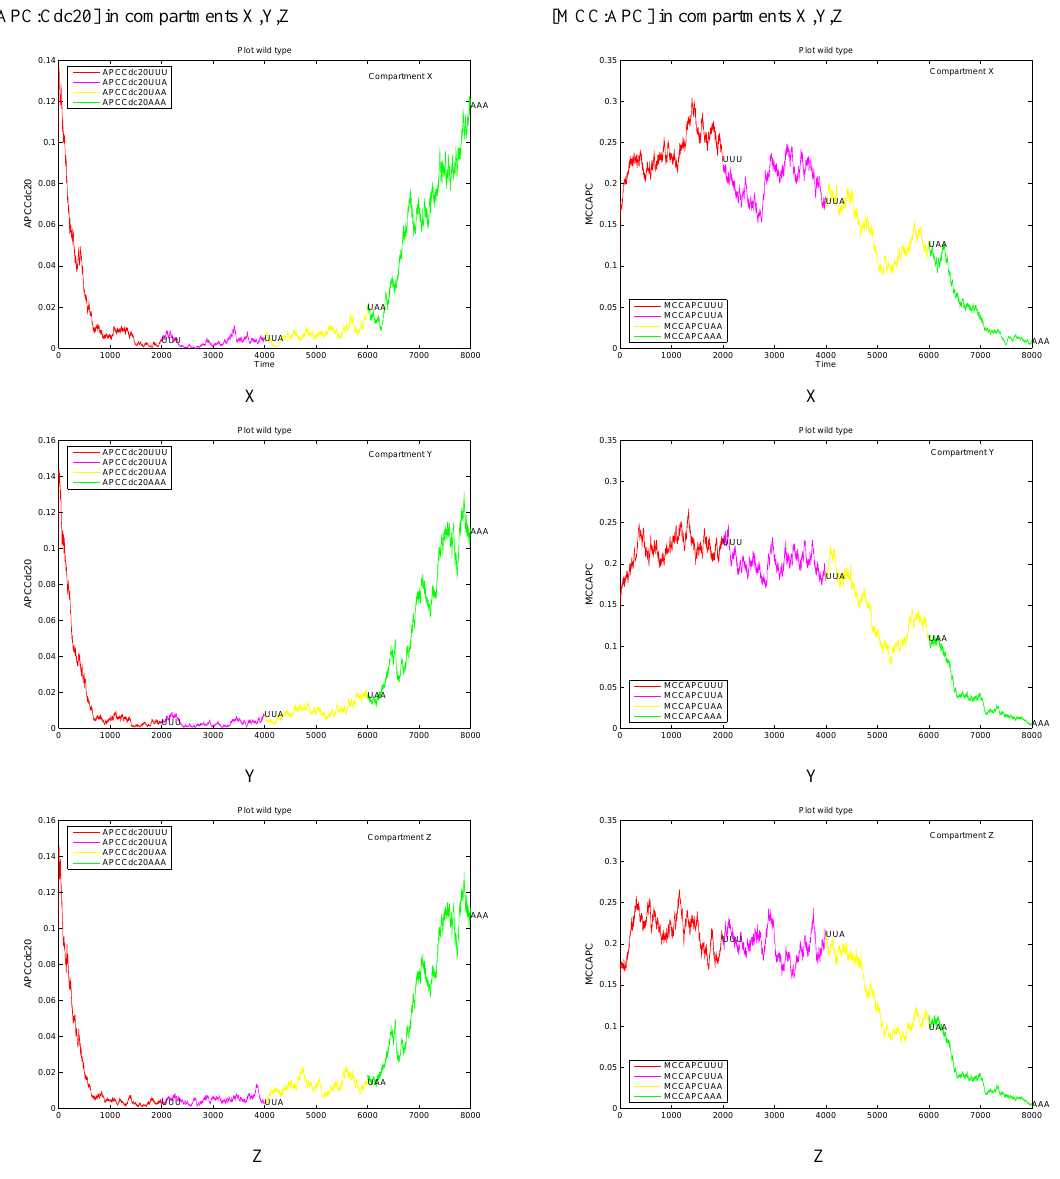
Figure 5: Concentration of APC:Cdc20 (left) and MCC:APC (right) in the three compartments X,Y,Z, at a noise amplitude of N = 10 − 5 for diffusion coefficient Ω = 0 . 005 . For these parameters, strong differences in the [APC:Cdc20] and [MCC:APC] dynamics in the different compartments become